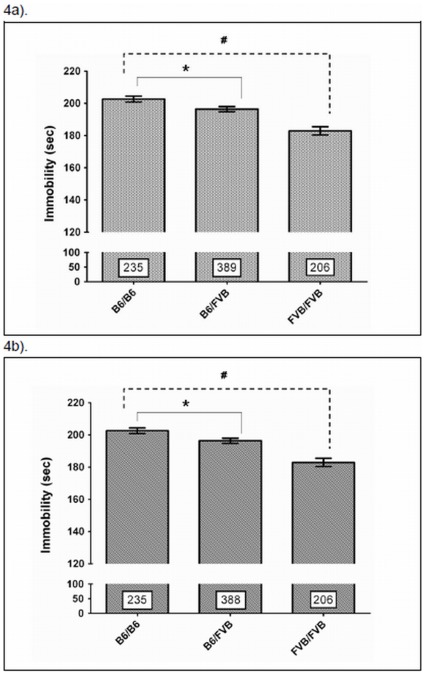
The association of mouse Zfp326 function SNP with FST response to fluoxetine treatment.Genetic variations in Zfp326, rs33550587 (Asp494Gly) (4a) and rs13473815 (4b), are associated with the mouse response to fluoxetine in the FST. The B6×FVB-F2 mice were grouped according to genotype. * p<0.05; #p<0.0001. The digits in the bars represent the number of animals in each group. Zfp326: zinc finger protein 326 gene; SNP: single nucleotide polymorphism; FST: forced swim test.